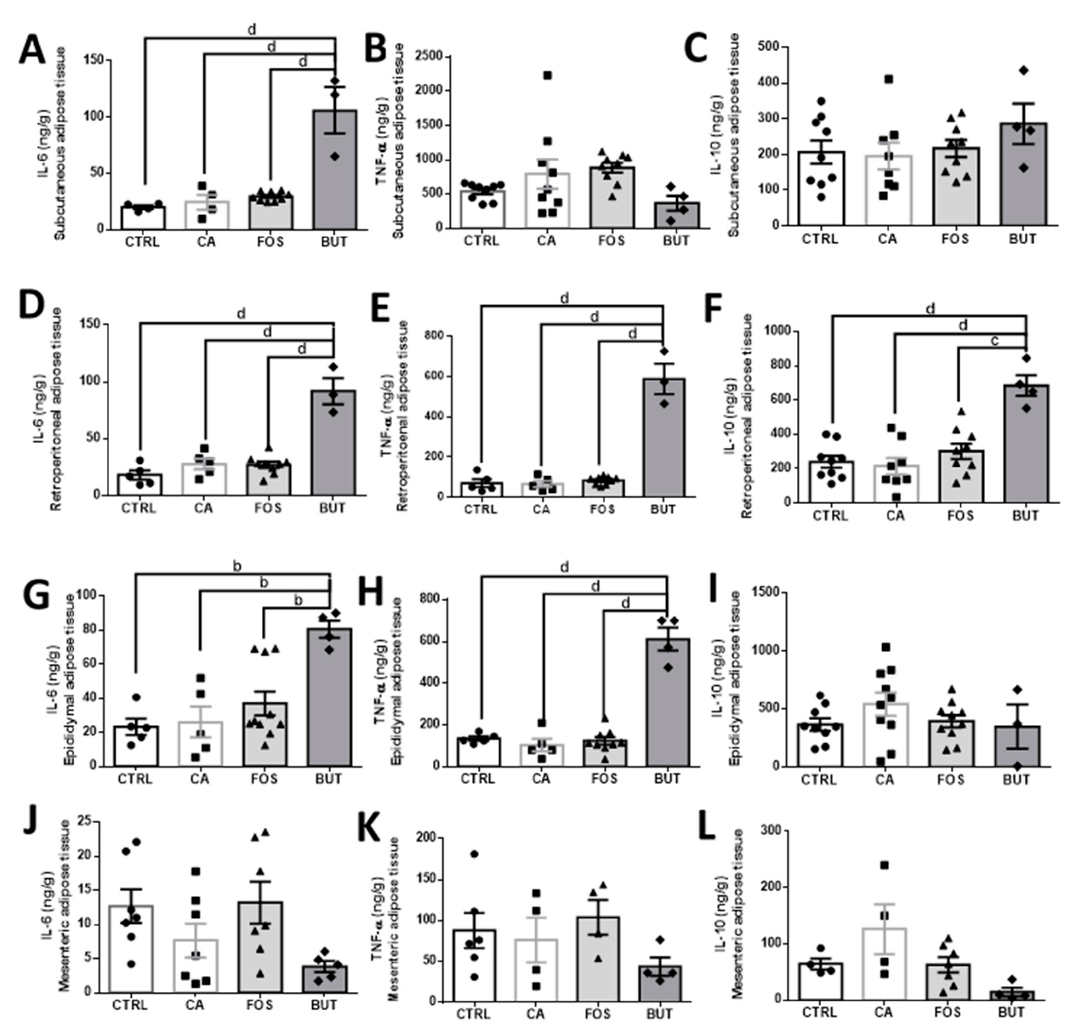
Figure 10. Butyrate promoted pro-inflammatory markers (IL-6 and TNF- α ) and IL-10 in different adipose depots: IL-6, TNF- α , and IL-10 concentrations in subcutaneous ( A – C ), retroperitoneal ( D – F ), epididymal ( G – I ), and mesenteric ( J – L ) adipose tissues. Mice were divided into four groups: control group (CTRL— n = 6–9) fed with chow diet; and colon carcinogenesis-induced groups fed either with chow diet (CA— n = 4–9), TB-supplemented diet (BUT— n = 3–4), or with FOS-supplemented diet (FOS— n = 5–9). Colon carcinogenesis was induced chemically by azoxymethane (AOM)/dextran sodium sulphate (DSS). Data are presented as means ± SEM. After outlier exclusion, the groups were compared using one-way ANOVA followed by Bonferroni post hoc tests; for p < 0.01 (b), p < 0.001 (c), and p < 0.0001 (d); black circles ( ● ), square ( ∎ ), triangles ( ▲ ), rhombus ( ◆ ) represents sample numbers in the corresponding group. reduced VEGF in mesenteric depot (Figure